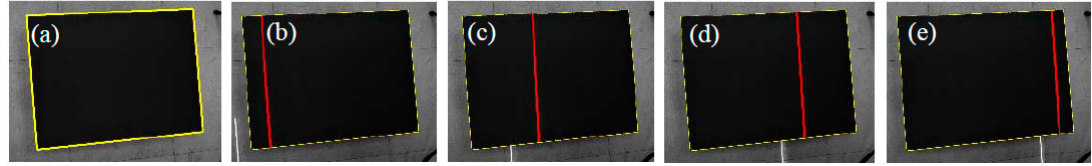
Figure 9. Images captured by the left camera: ( a ) the first image without laser stripe; ( b ) the 10th image; ( c ) the 30th image; ( d ) the 50th image; ( e ) the 70th image.